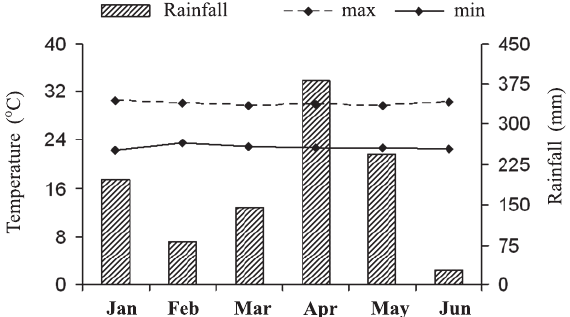
figure 1. temperature and rainfall during the experiment.